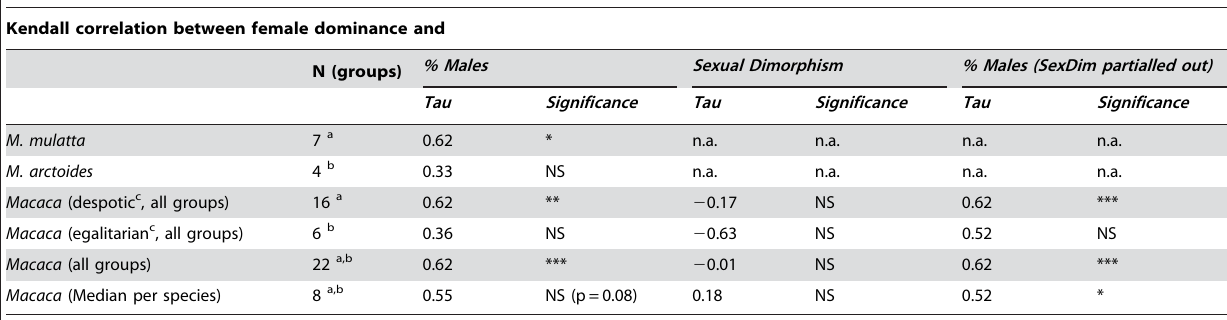
Table 3. Kendall correlation between female dominance, percentage of males and sexual dimorphism.